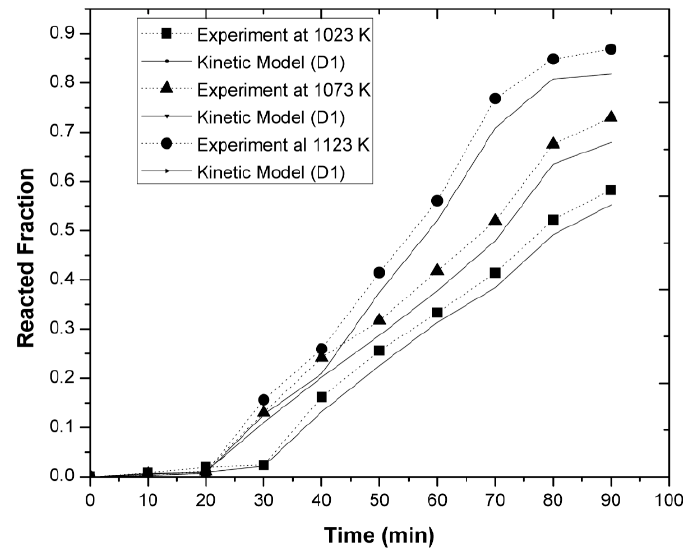
Figure 16. Experimental results and prediction of the D1 model at different temperatures for alloys with an initial Mg concentration of 3 wt-%, at 300 rpm.